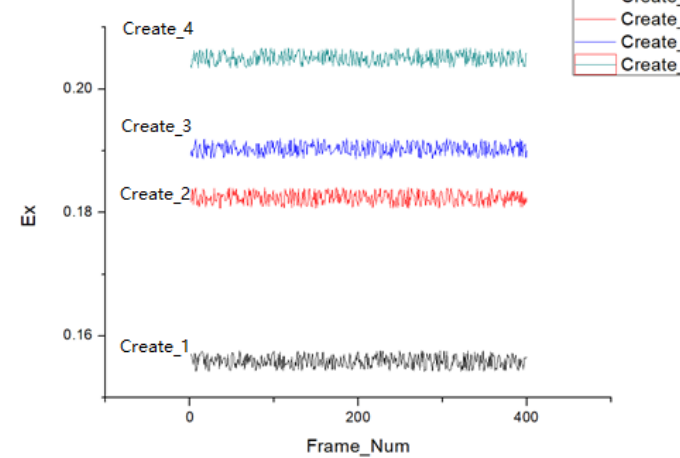
Fig. 3 The completeness distance index result between the generated data and the original